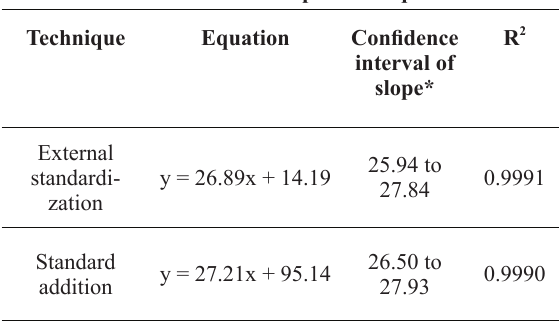
Equations of the analytical curves based on external standardization and standard addition to the sample